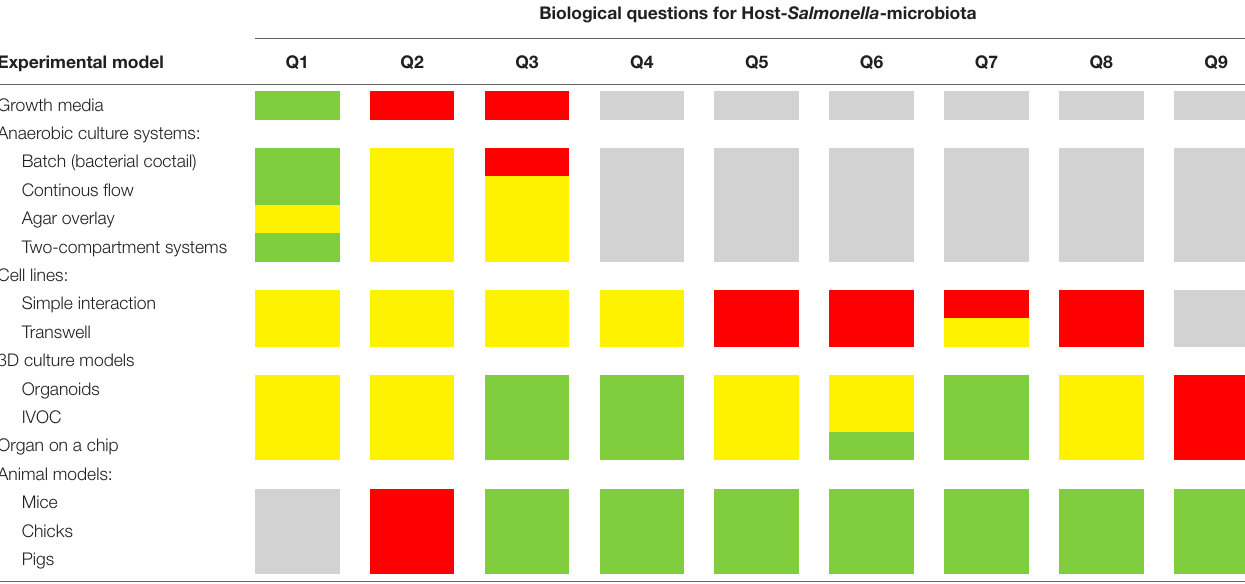
TABLE 1 | Lesson learned from different models for Salmonella -host-microbiota interactions. Biological questions for Host- Salmonella